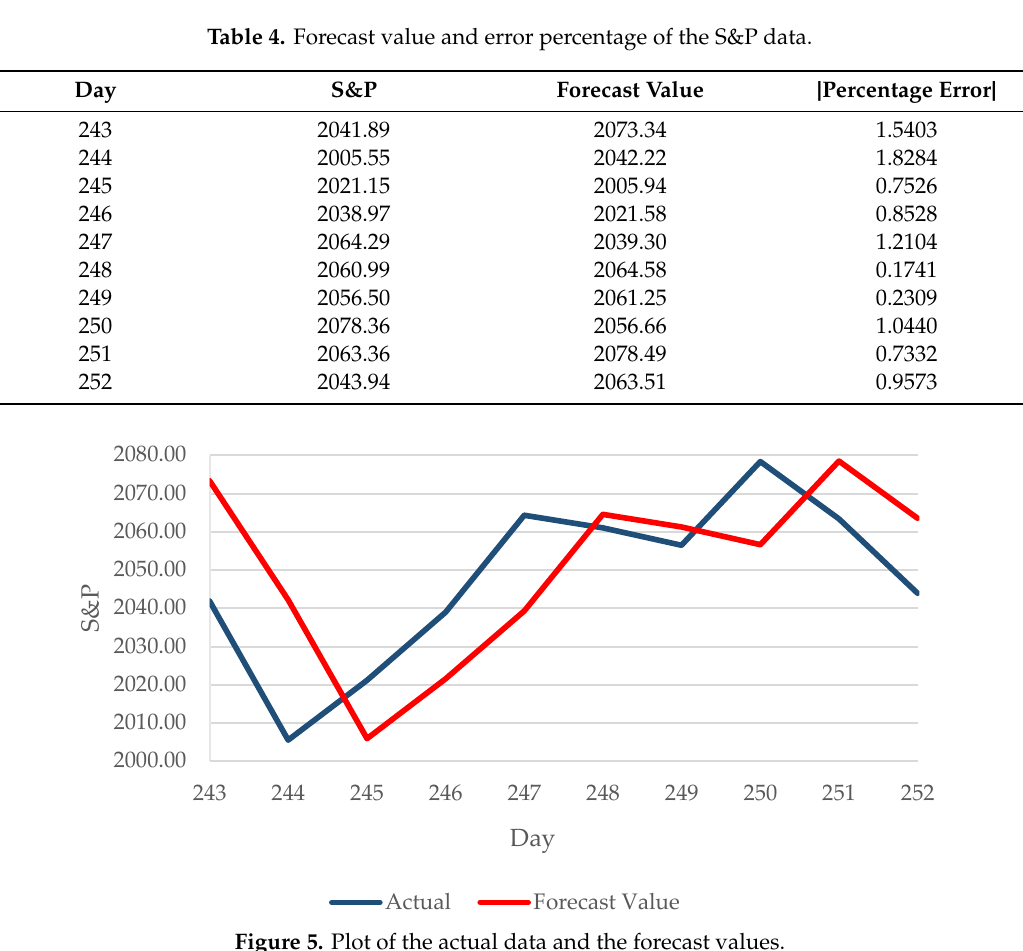
Table 5. Mean absolute percentage error ( MAPE ) of the datasets for different models.